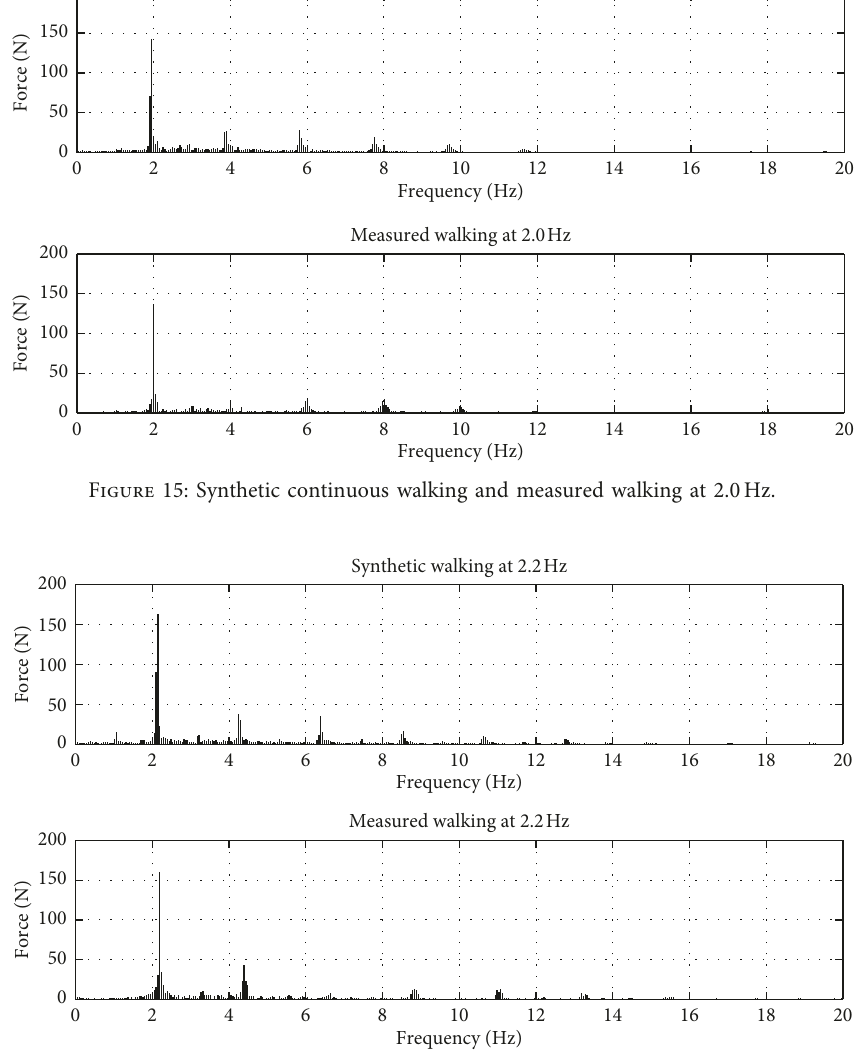
Figure 16: Synthetic continuous walking and measured walking at 2.2Hz. Table 2: Spread of energy in the spectra for the synthetic and measured walking. Harmonic number Area synthetic